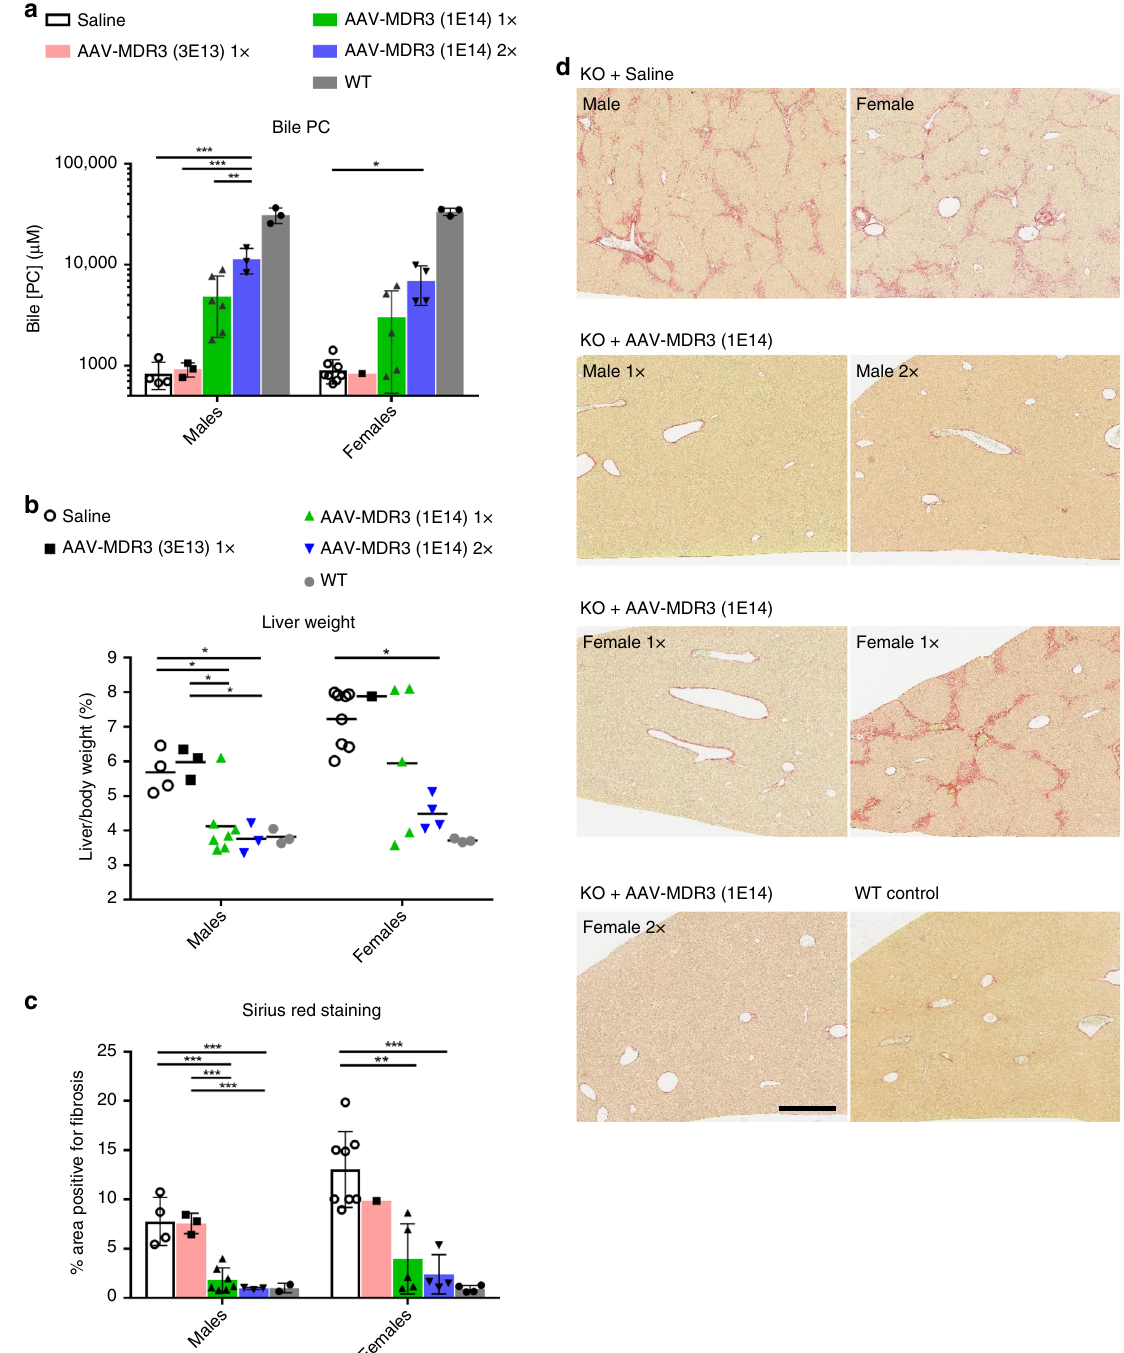
Fig. 4 Biliary PC and evidence of cholestasis for Abcb4 − / − mice treated with AAV-MDR3-Aco. At the time of sacri fi ce, PC concentration in bile ( a ) and liver weight as a percent of body weight ( b ) were measured for Abcb4 − / − mice treated with AAV-MDR3-Aco at 3 × 10 13 VG/kg 1× (pink bars or black squares; n = 3 M/1 F), at 1 × 10 14 VG/kg 1× (green bars or green triangles; n = 7 M/5 F), or at 1 × 10 14 VG/kg 2× (blue bars or blue inverted triangles; n = 3 M/4 F), as well as saline-treated controls (white bars or open circles; n = 4 M/8 F) and untreated WT mice (grey bars or grey circles; n = 3 M/3 F). Liver sections were stained with picrosirius red to indicate fi brosis ( d ) and the amount of tissue with red staining was quanti fi ed ( c ). Representative pictures from one mouse in each group are shown, except for females treated 1× at 1 × 10 14 VG/kg, for which one animal each from both responder (left image) and non-responder (right image) groups is shown. Scale bar = 500 μ m. Statistics (one-way ANOVA/Tukey ’ s multiple comparisons test): *, p < 0.05; **, p < 0.01; ***, p < 0.001; data are presented as mean ± SD; F values and degrees of freedom (numerator, denominator): a males: F (3,12) = 14.52, females: F (3,15) = 4.58; b males: F (3,13) = 8.548, females: F (3,14) = 4.501; c males: F (3,13) = 23.13, females: F (3,14) = 11.58. Source data are provided as a Source Data fi